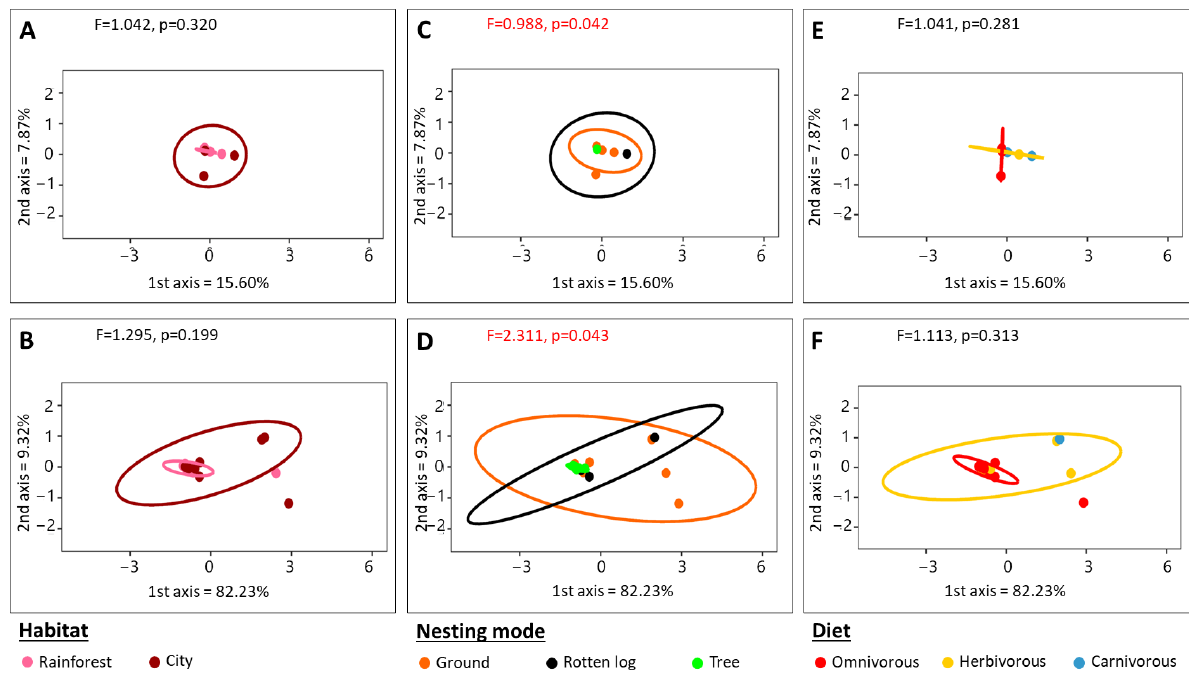
Figure 4. Differences in microbial eukaryote communities visualized with PCoAs across ant habitats ( A , B ), nesting modes ( C , D ), and diets ( E , F ). The distances used were the Bray – Curtis ( A , C , E ) and wUniFrac ( B , D , F ). The statistical p -values were obtained with pairwise PERMANOVAs. The circles represent confidence intervals of 0.95.